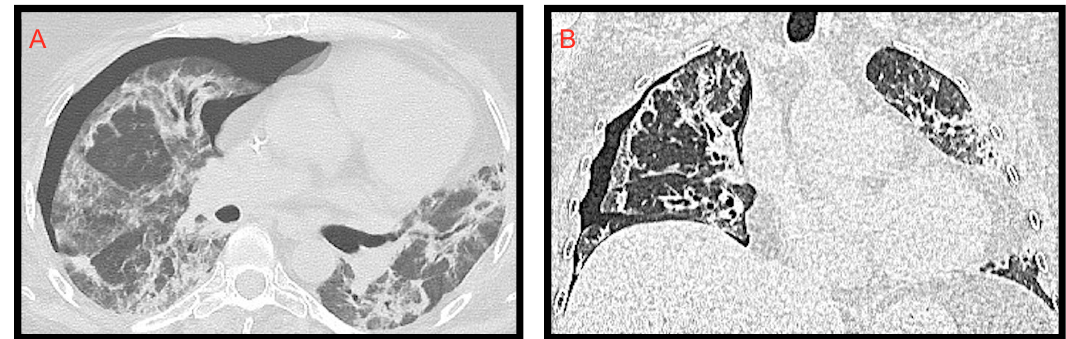
Figure 7. Spontaneous right pneumothorax extended from apex to lung base. Axial ( A ); coronal ( B ); the right lung appears hypo-expanded.